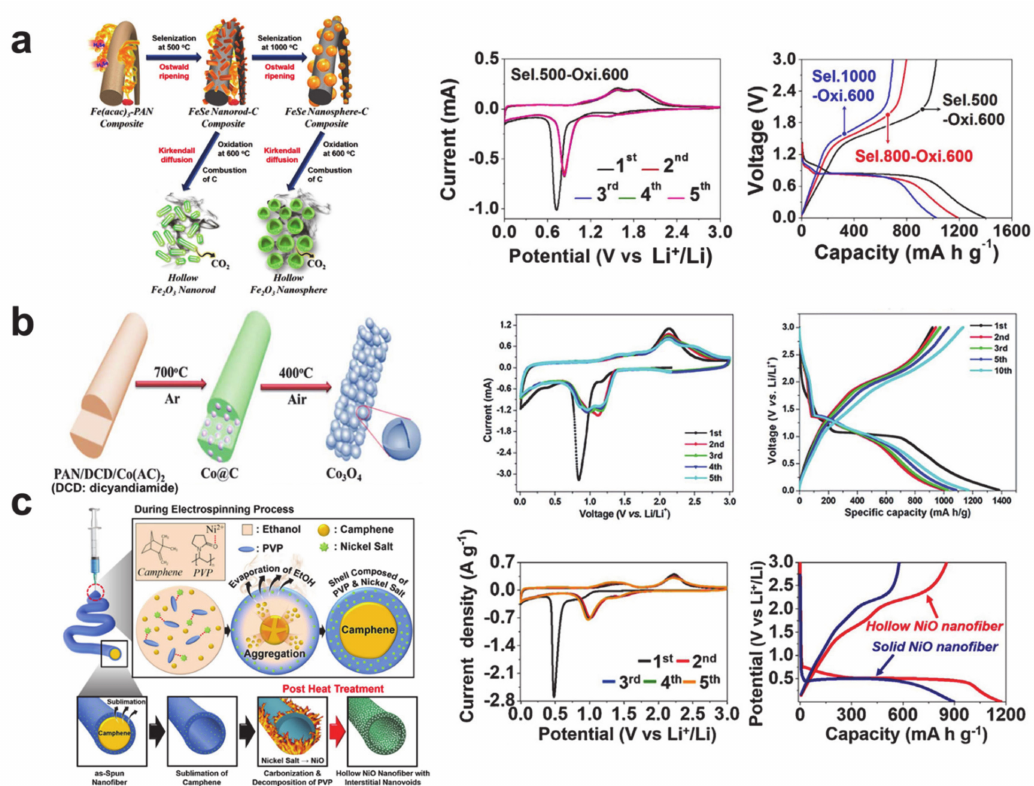
Figure 9. Schematic illustrations of hollow nanostructured transition metal oxide anode materials and corresponding electrochemical performances. ( a ) Fe 2 O 3 nanostructures (reprinted with permission from [125]; copyright 2016 Springer Nature), ( b ) hollow Co 3 O 4 nanostructure (reprinted with permission from [127]; copyright 2019 Royal Society of Chemistry), and ( c ) hollow NiO nanofiber (reprinted with permission from [130]; copyright 2019